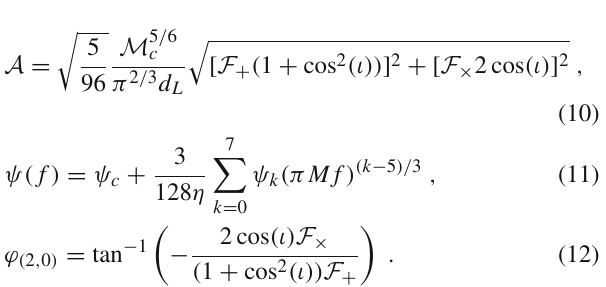
Fig. 4 The 1D PDFs and the 2D contours for the independent param- eters in the Ω k w CDM model